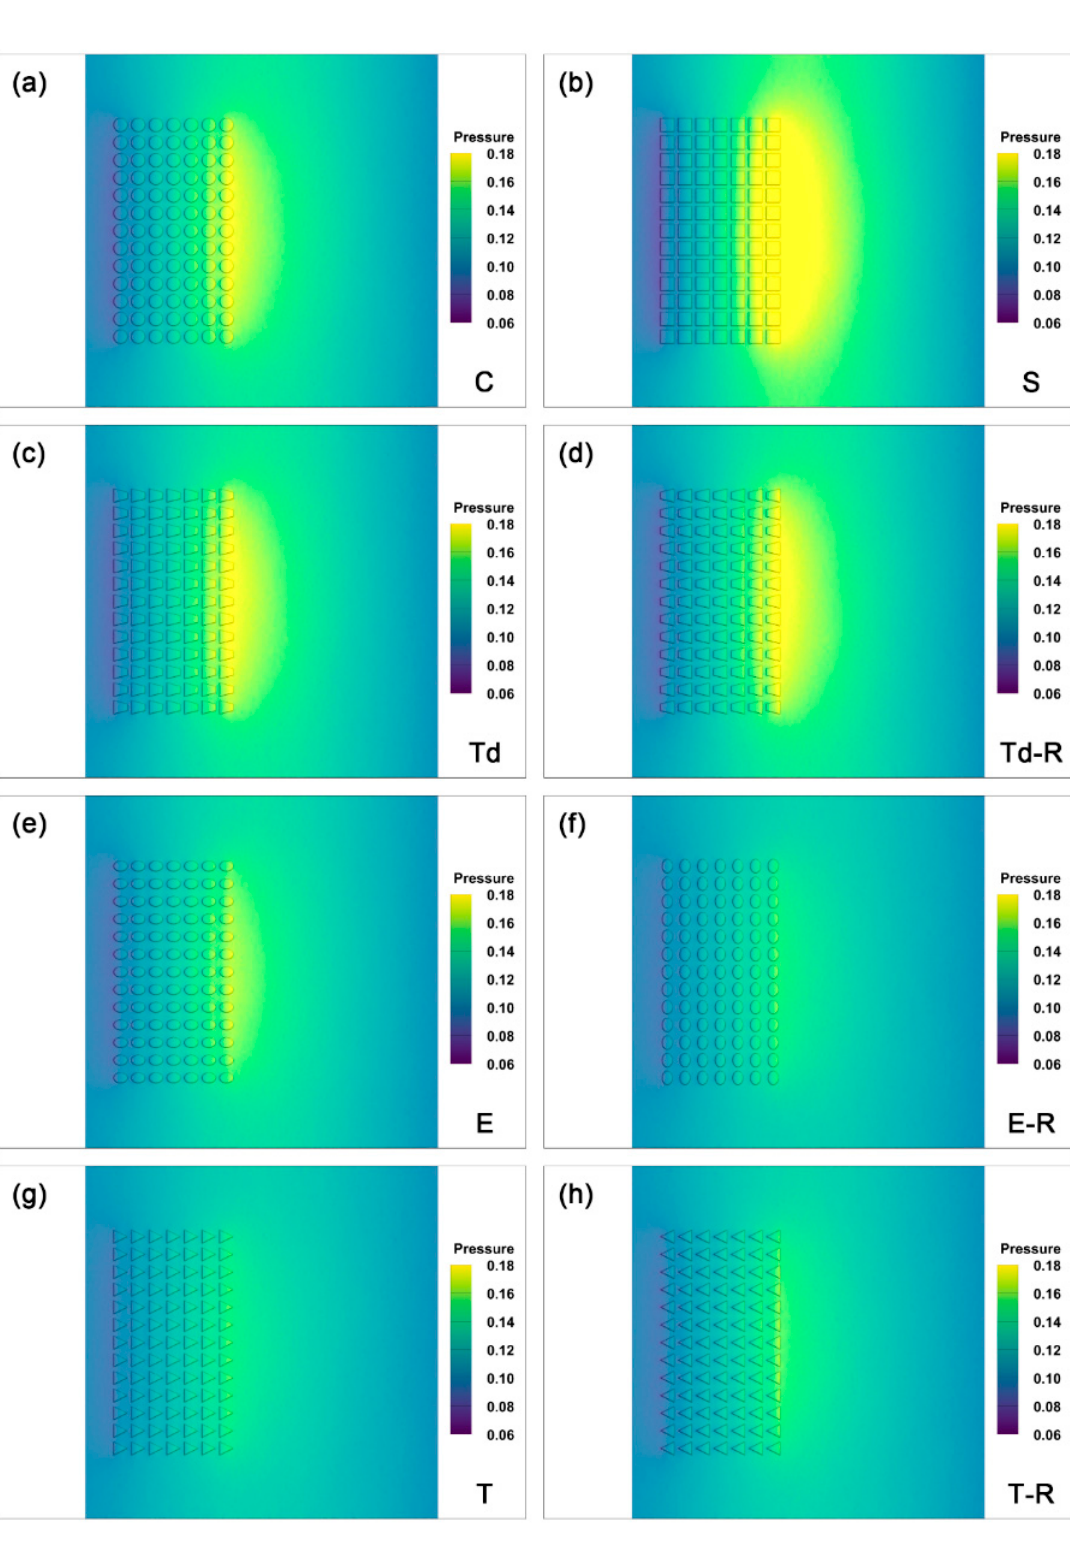
Figure 5. Pressure distributions on the bottom surface of the model for the circle ( a ), square ( b ), ellipse ( c ), rotated ellipse ( d ), trapezoid ( e ), rotated trapezoid ( f ), triangle ( g ), and rotated triangle ( h